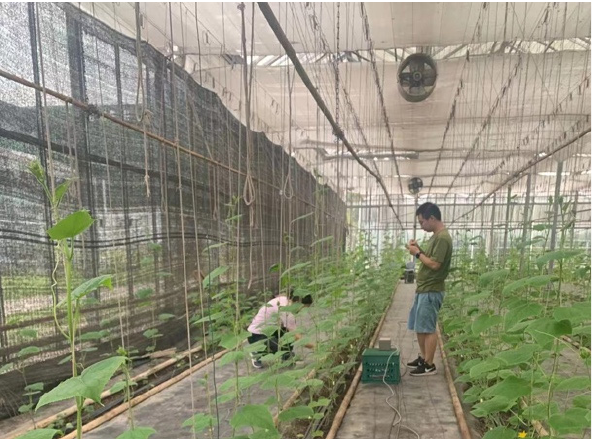
Figure A2. A picture of the experimental greenhouse, taken during the digitization of cucumber